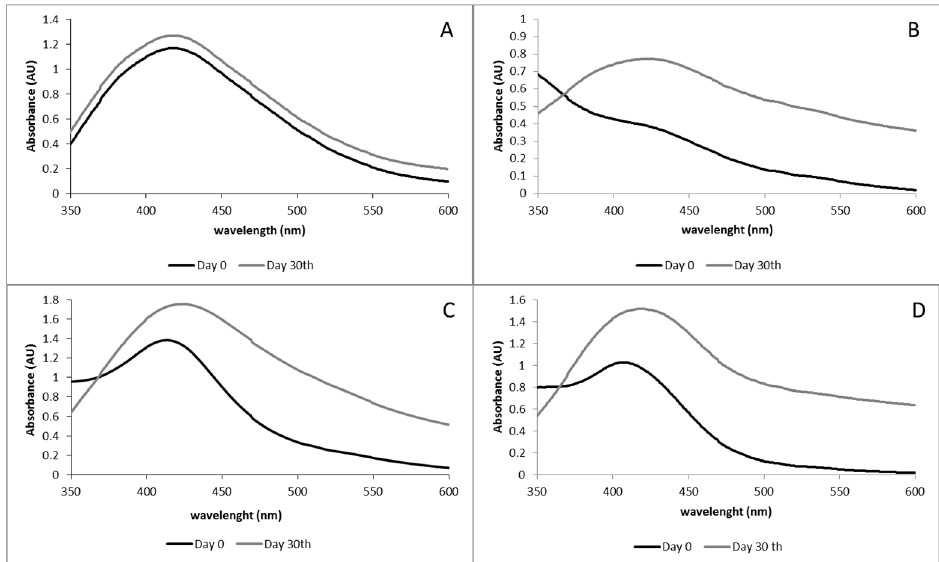
Figure 6. Ultraviolet–visible spectra of AgNPs synthesized using different low molecular weight chitosan fractions as reducing and stabilizing agent. ( A ) F1Q, ( B ) F1L, ( C ) F2L, and ( D ) F3L.